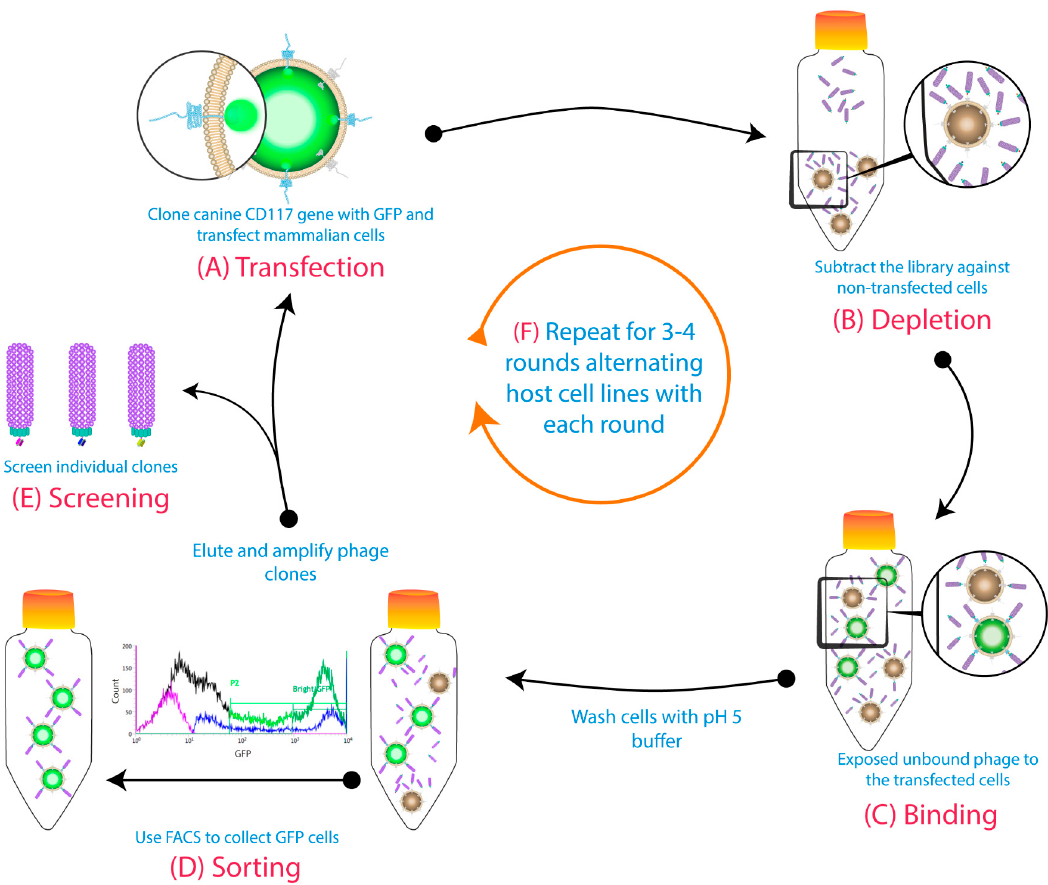
Figure 1. Cell-based biopanning protocol using cell sorting and alternative host cell lines: ( A ) The gene for the target membrane protein was cloned in-frame with Green Fluorescent Protein (GFP) to be expressed on the cell surface. ( B ) The phage library was subtracted on untransfected cells. ( C ) Then, the free phages were panned against transiently transfected cells. ( D ) A pH 5 wash step was conducted before GFP-positive cells were collected using fluorescence-activated cell sorting (FACS). The binders from the sorted cells were eluted with a low pH buffer, then amplified for the subsequent rounds. ( E ) Individual clones were screened at the end of biopanning campaigns. ( F ) The host cell line was alternated each round (first round: Chinese hamster ovary (CHO) cells; second round: Human embryonic kidney 293 cells (HEK293), etc.). Figure shows methodology described by Jones et al. (2016)